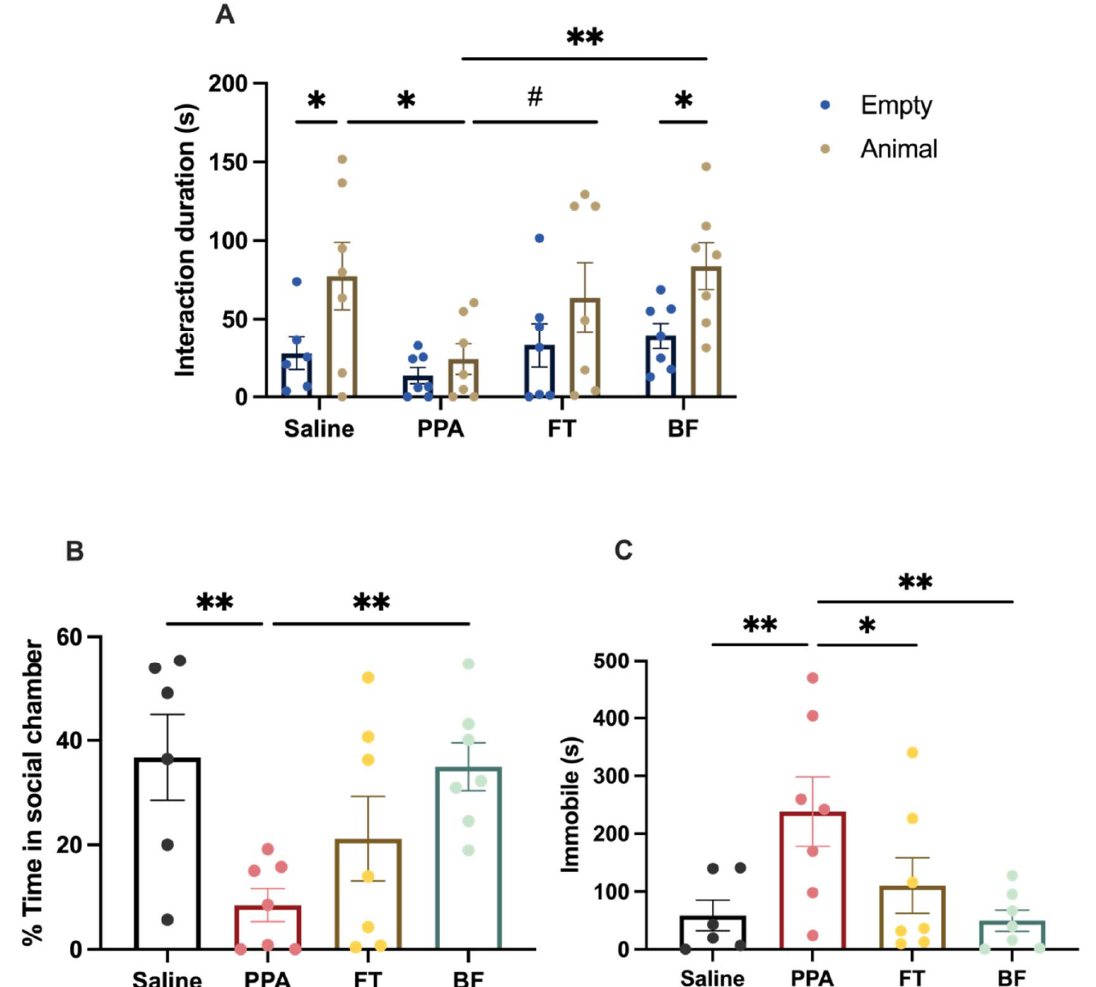
Figure 2. Social interaction in the three-chamber social test following saline ( n = 6) and propionic acid (PPA) ( n = 7) treatments, and fecal transplant (FT) ( n = 7) and Bifidobacterium (BF) interventions ( n = 7): ( A ) time spent by focal animals interacting with the conspecific animal and the empty holding box during the three-chamber social test; ( B ) percentage of time spent in the social chamber relative to other chambers; ( C ) time spent immobile during the test. Data presented are means ± standard error. Significant two-way and one-way ANOVAs were followed by multiple comparisons by Fisher’s least significance difference ** p ≤ 0.01, * p ≤ 0.05, # p = 0.06.